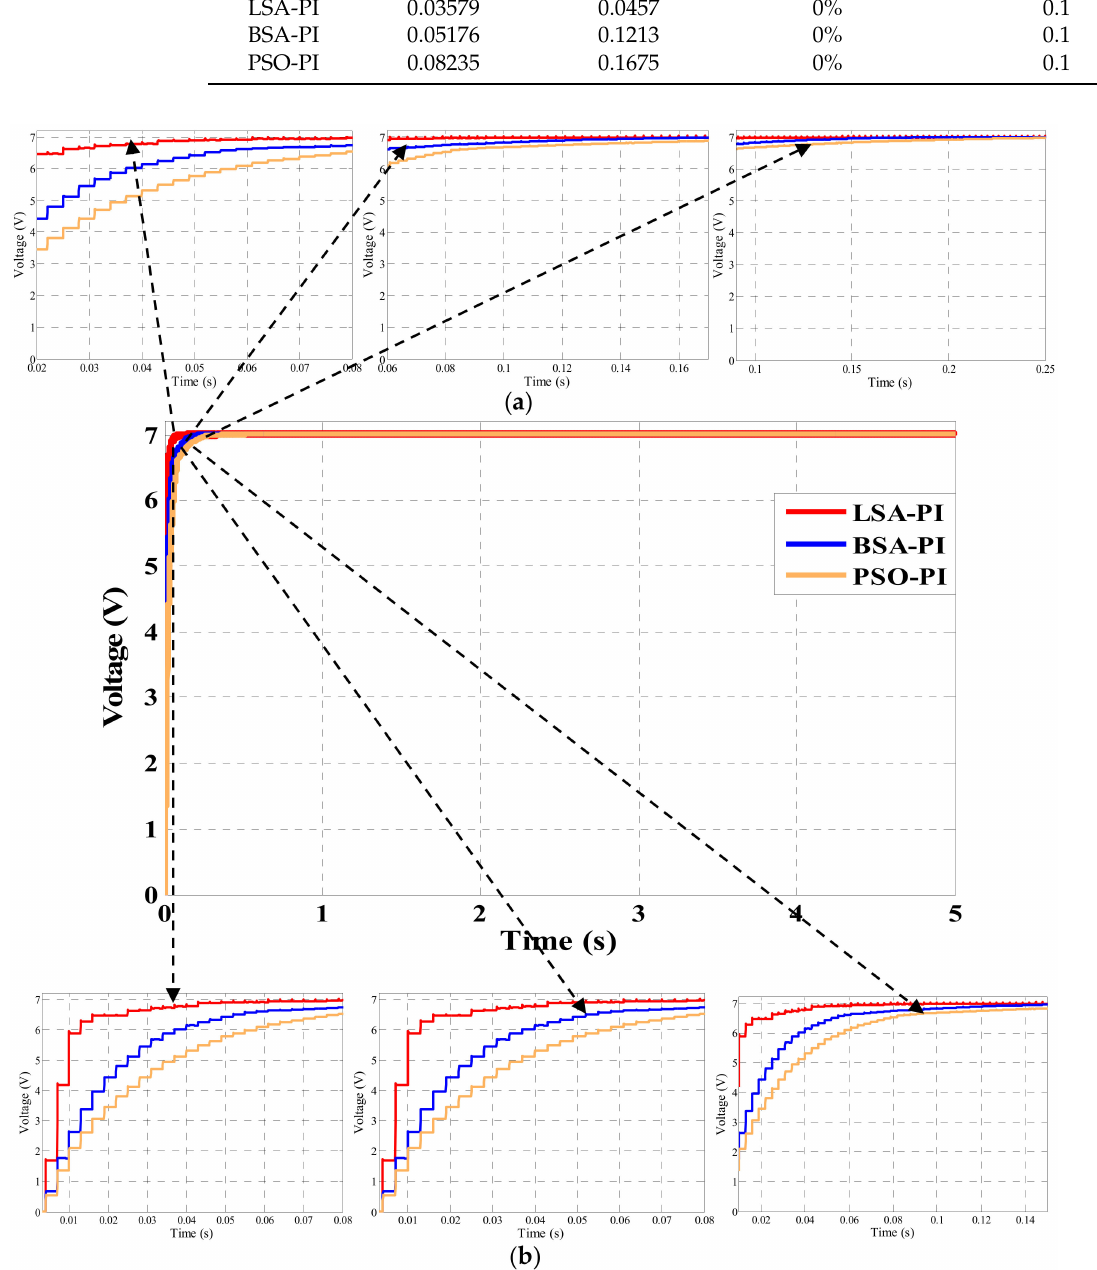
Figure 16. Simulation results hybrid optimization and PI voltage controller approach with rise time ( a ) and settling time; ( b ) for a 300 mV